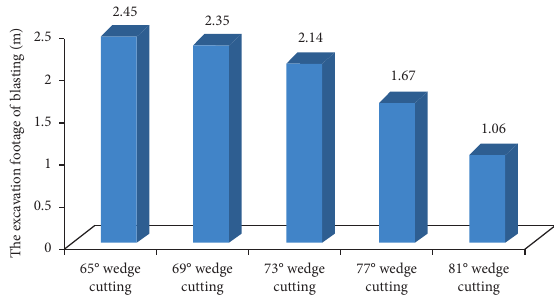
Figure 28: Comparison chart of tunneling footage when tunnel blasting cutting angle